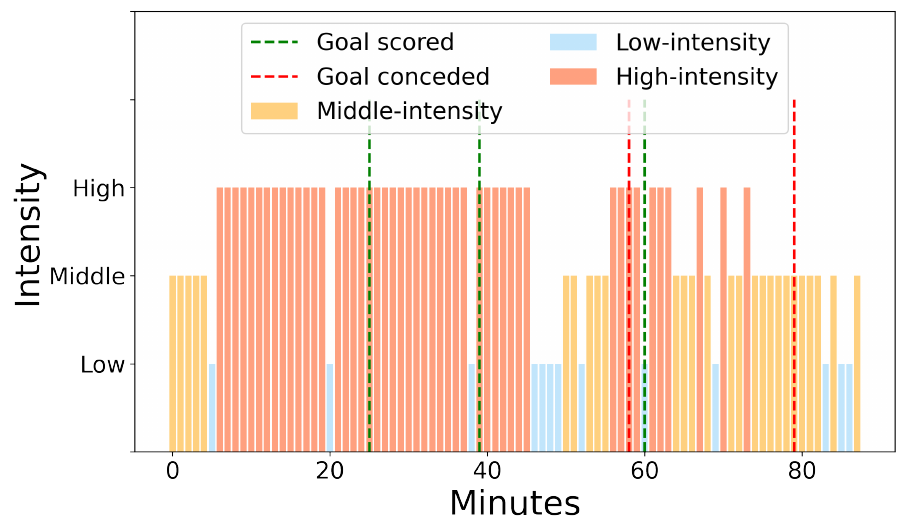
Figure 7. Intensity clusters across a 90-min period with the score-change timestamps for a single player in a particular game. High intensity is represented with brown–red, middle with yellow– orange, and low intensity with blue. Vertical discontinued red lines are goals conceded, and green ones are goals scored.